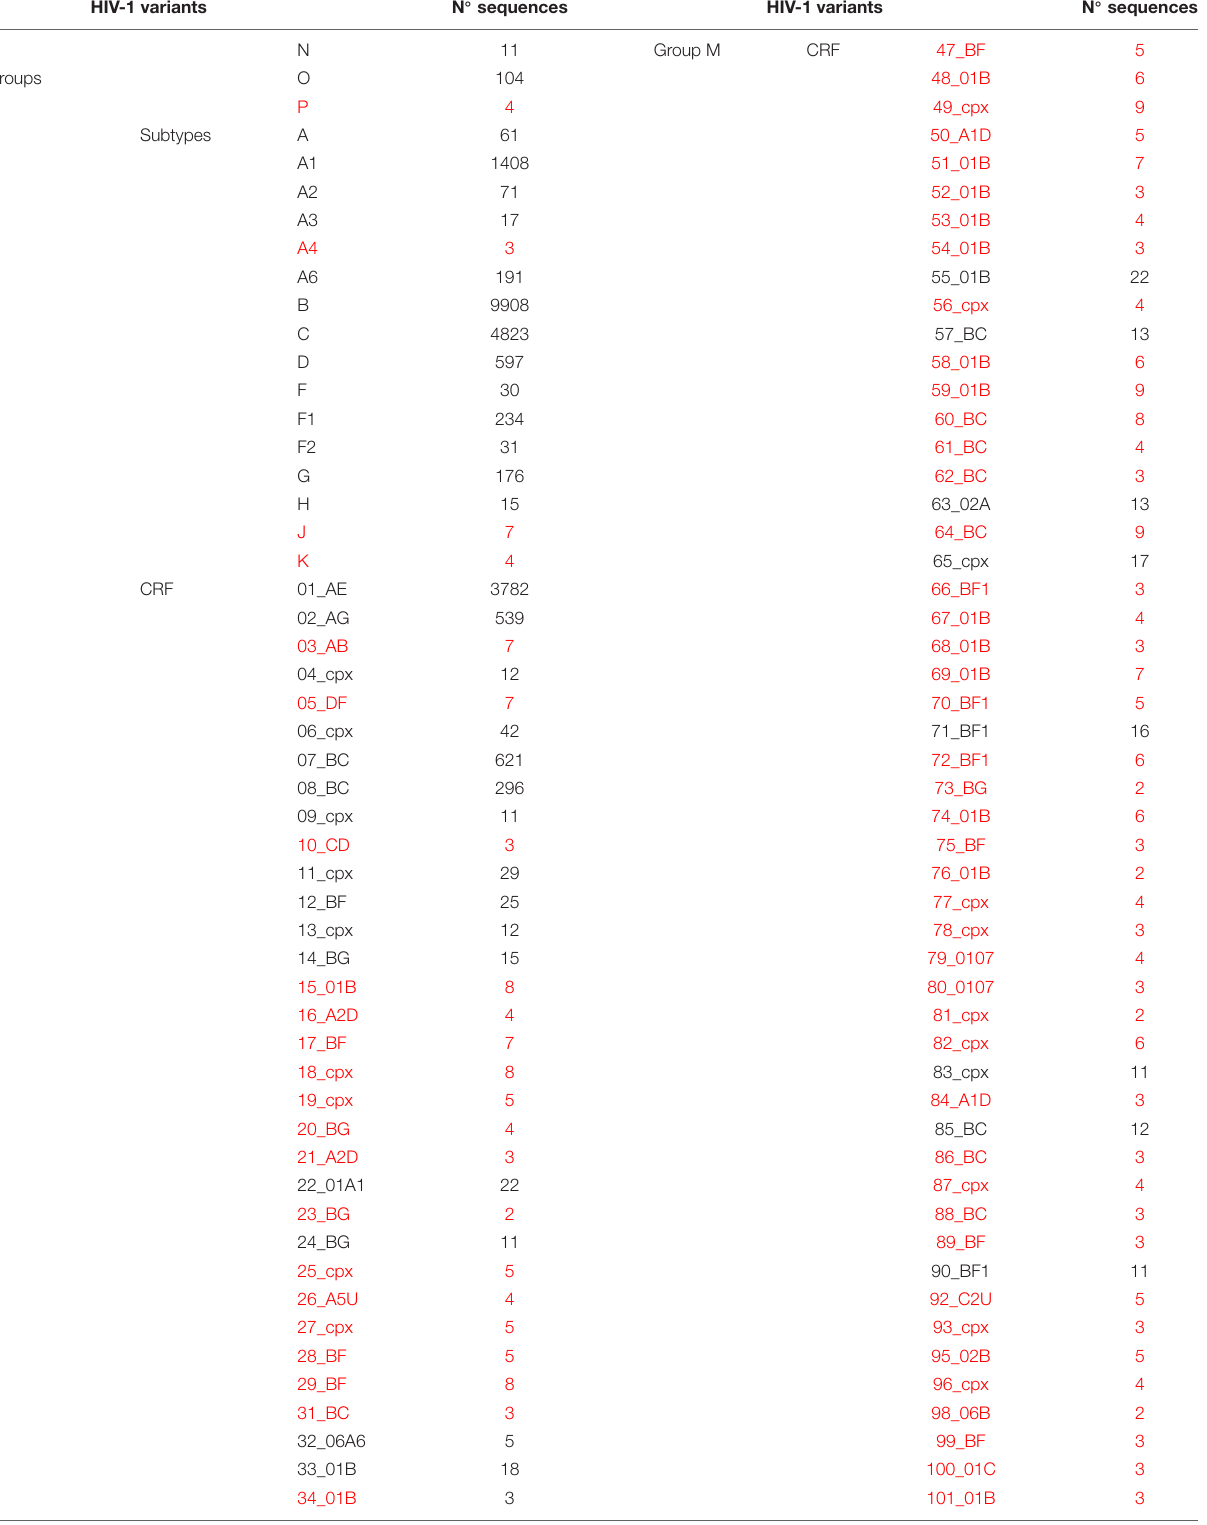
TABLE 1 | HIV-1 p24 Los-Alamos National Library (LANL) sequences analyzed in the present study. HIV-1 variants N ◦